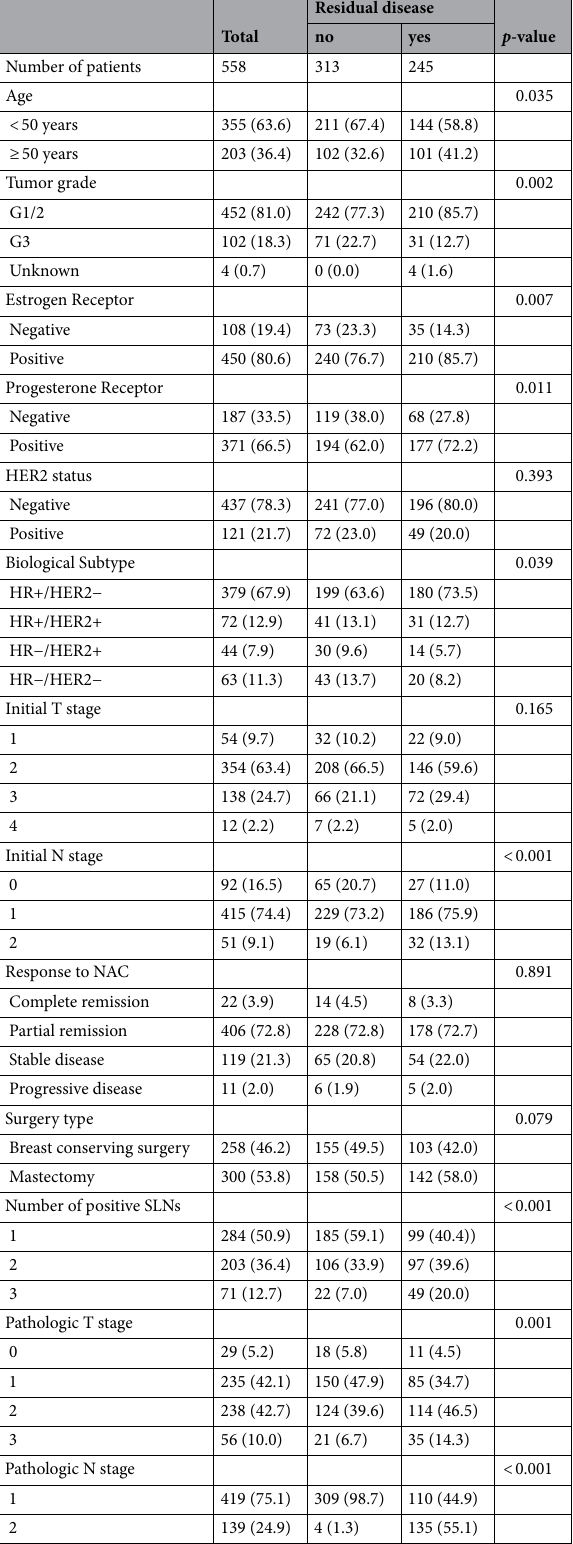
Table 1. Baseline patient characteristics and association between residual disease and clinicopathologic variables. SLN (Sentinel Lymph Node). NAC (Neoadjuvant chemotherapy). Response to NAC: followed the Revised Response Evaluation in Solid Tumors (RECIST) guideline, version